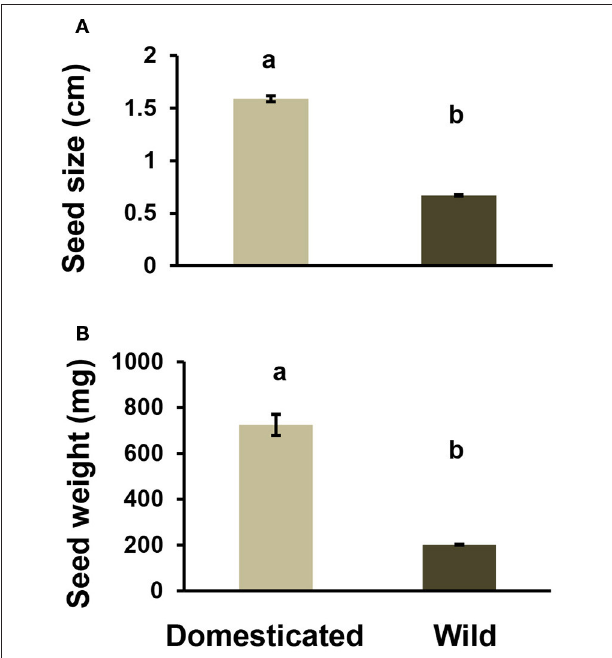
FIGURE 2 | (A) Mean size of domesticated and wild bean seeds. [ N = 40, F (1.74) = 172.8, p < 0.001]. (B) Mean weight of domesticated and wild bean seeds. [ N = 40, F (1.74) = 281, p < 0.001]. Different letters indicate a significant difference. Bars are means ± SE.